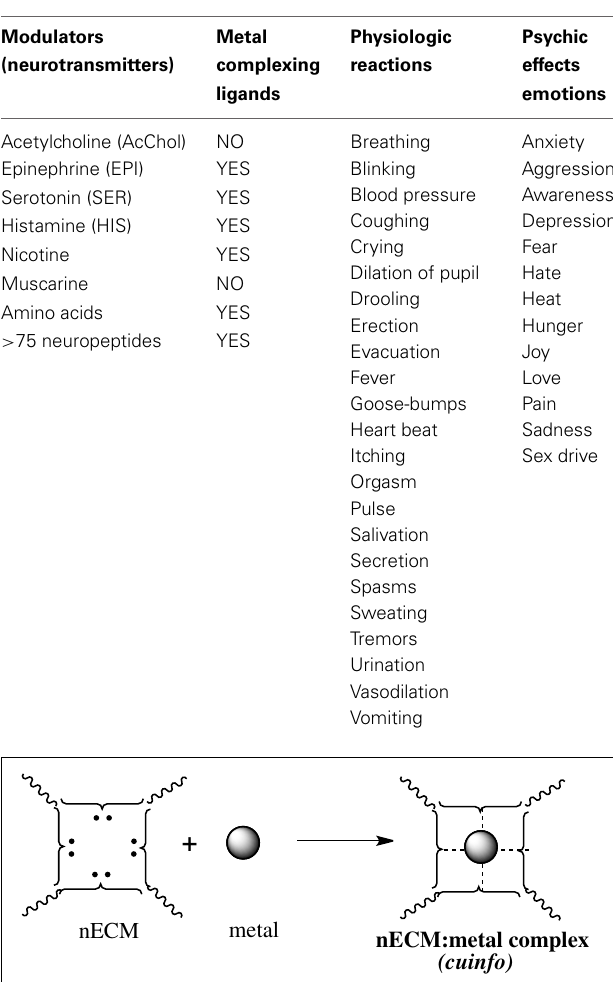
Table 1 | Metal complexing neurotransmitters. Table 2 | Bio-modulators (also called NTs) of physiologic responses to stimuli, which simultaneously elicit both physiologic responses and psychic (emotions) feelings, which also encode the stimuli, aiding the recall (memory).